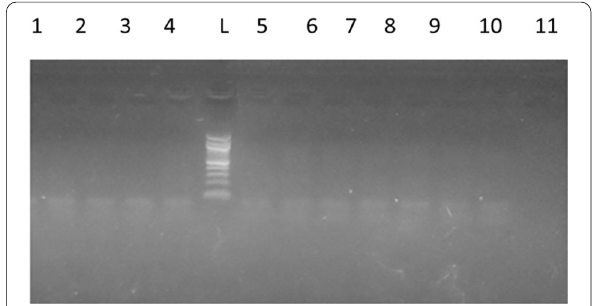
Fig. 3 A representative of the agarose gel electrophoresis of qnrS gene